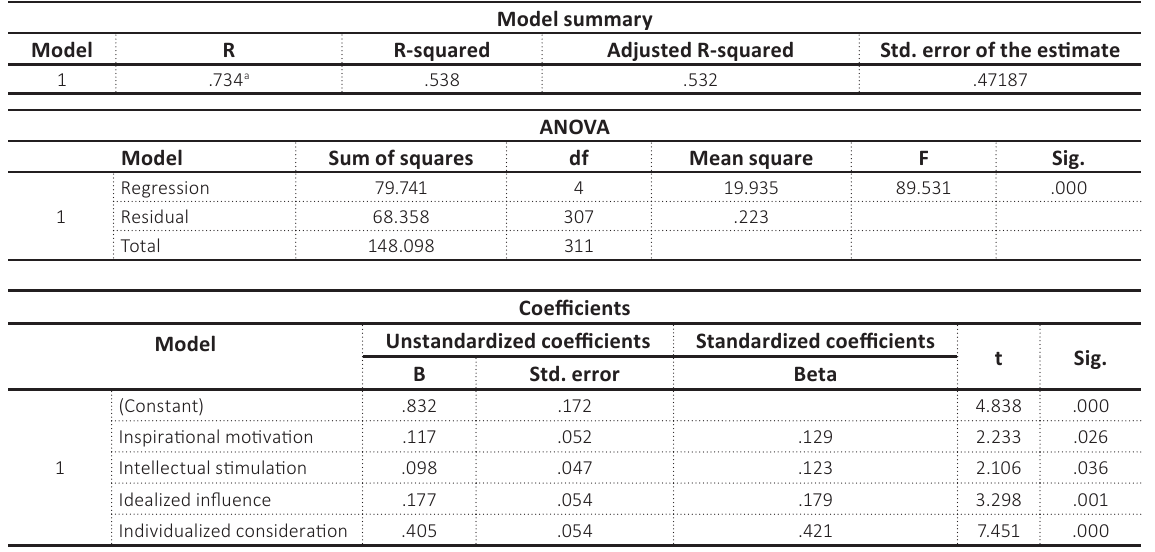
Table 5. Testing main hypotheses